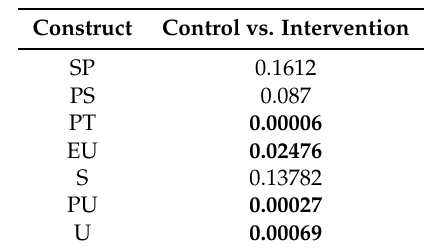
Table 5. Mann–Whitney–Wilcoxon test p